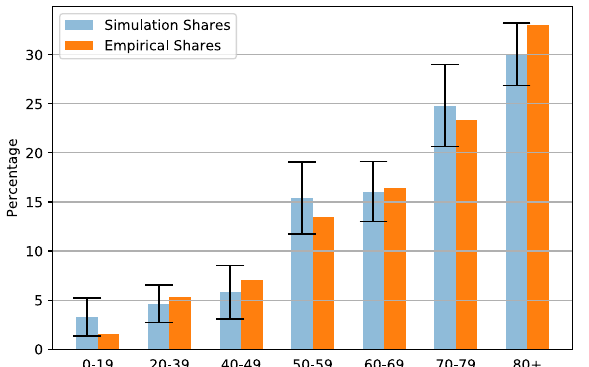
Figure 1. Share of hospitalized by age group.